Question: What style of plot is this figure drawn as?
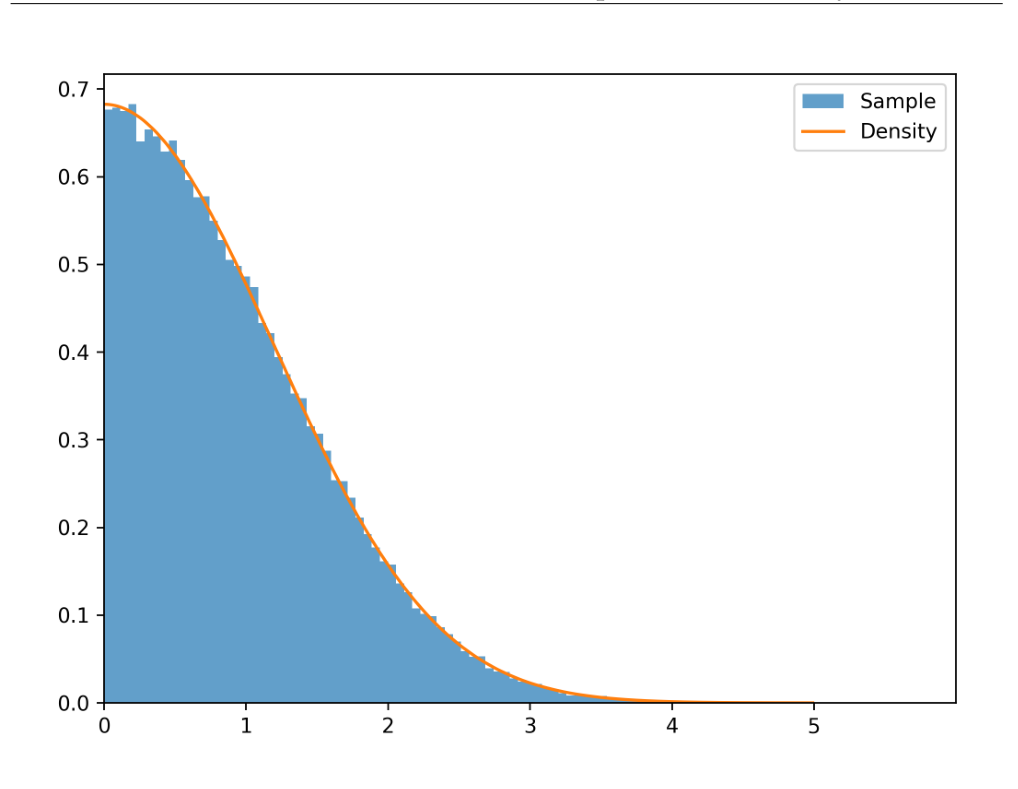
Answer: histogram